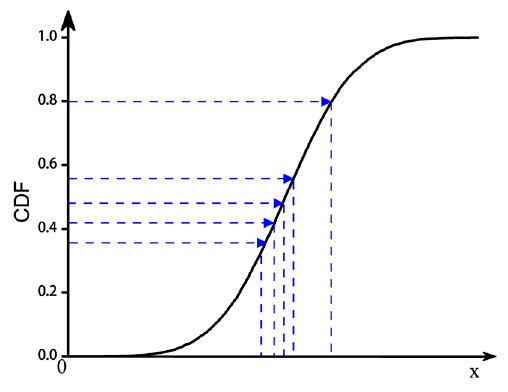
Figure 5. Monte Carlo sampling.